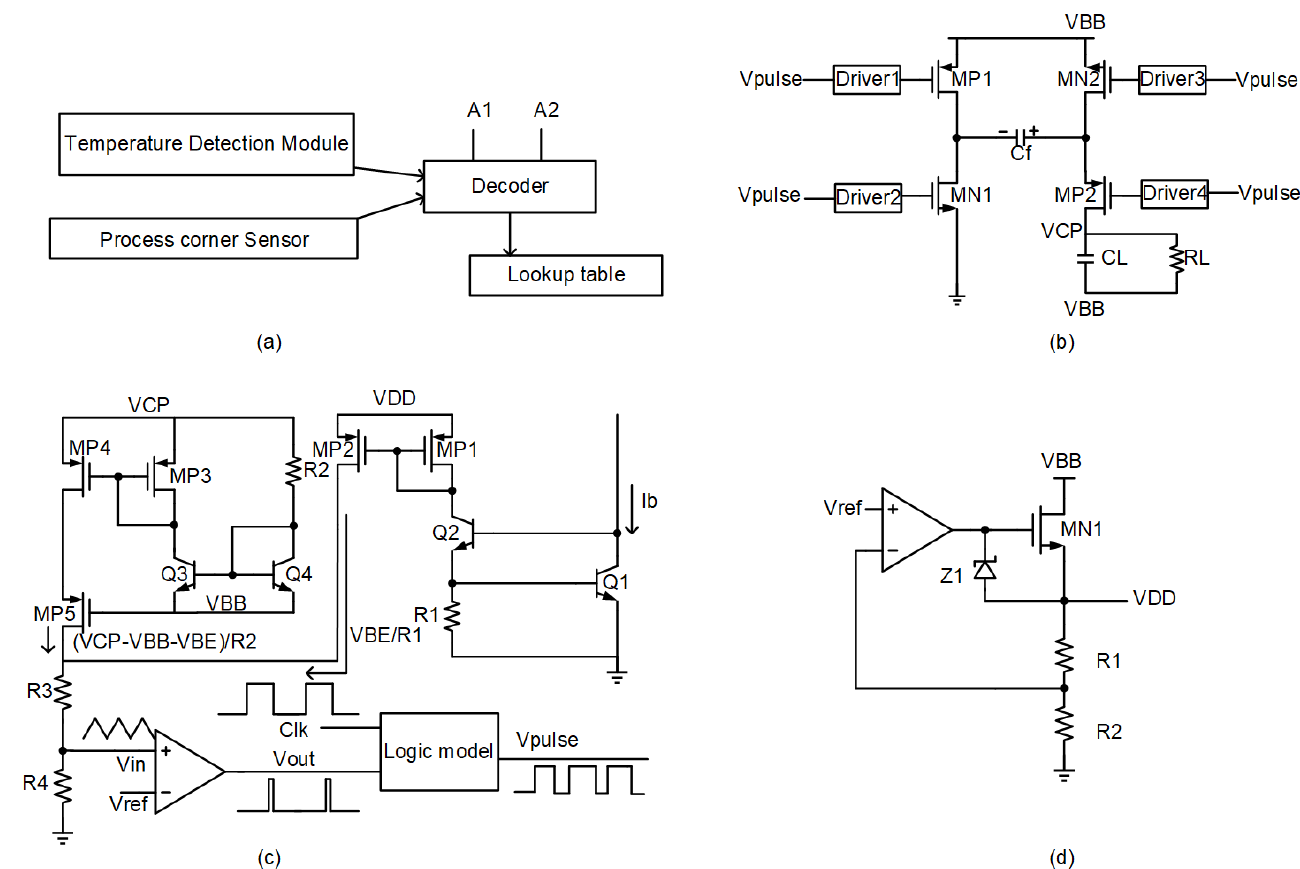
Figure 1. ( a ) Output voltage modulation module; ( b ) switched capacitor module; ( c ) PWM modula- tion module; and ( d ) high-voltage LDO